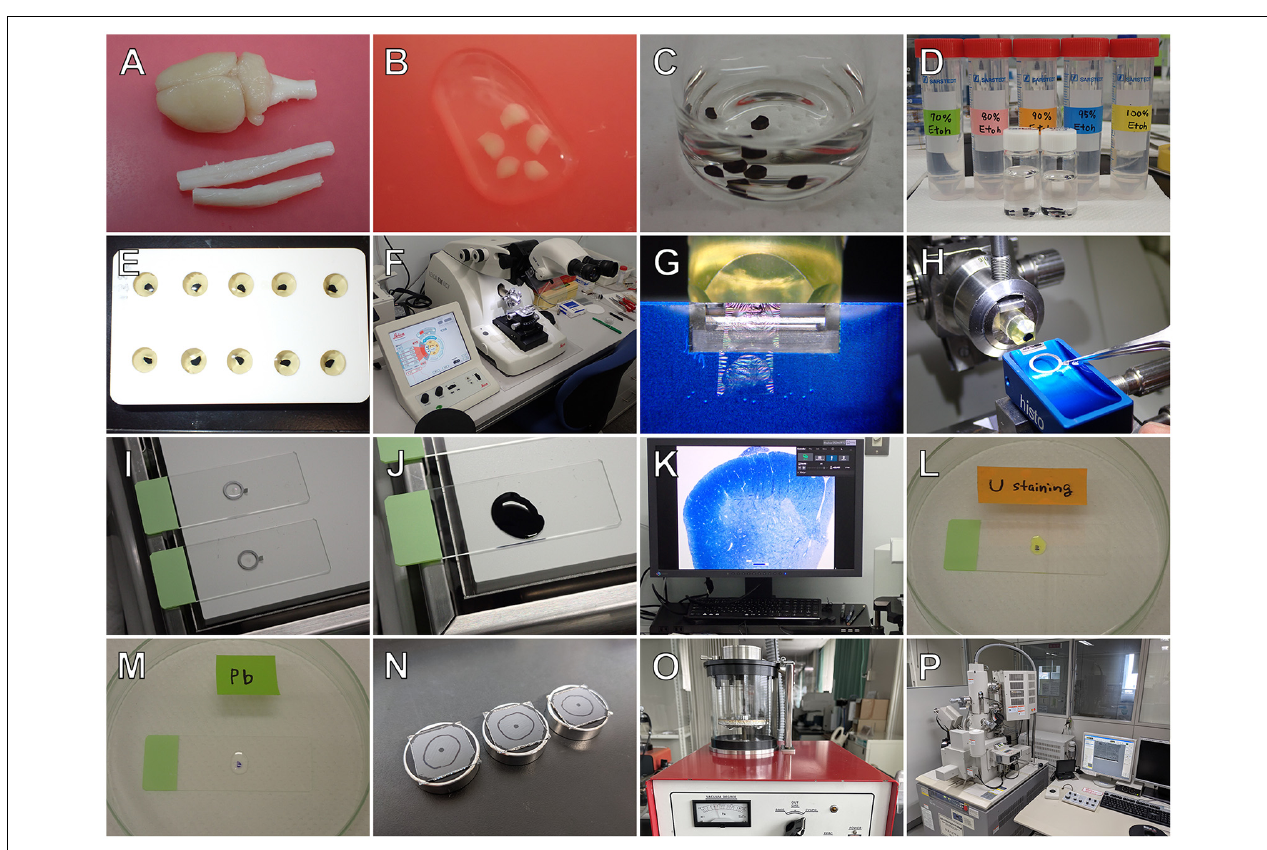
FIGURE 2 | Outline of semithin section SEM. After perfusion fixation, tissues are removed (A) , cut into small pieces (B) , postfixed with osmium tetroxide (C) , dehydrated with a graded series of ethanol (D) , and embedded in epoxy resin (E) . Resin-embedded semithin sections (500-nm thickness) are cut using a Histo knife (Diatome) (G) in an ultramicrotome (EM UC-7; Leica) (F) , picked up with an aluminum loop (Transfer Ring; Microstar) (H) , attached on glass microscope slides by heating on a hot plate (I) , and stained with toluidine blue (J) . The semithin sections are observed using light microscopy (LM) (K) , and the regions of interest are photographed using a charge coupled device camera (DP27; Olympus). The sections are subsequently stained with heavy metals of uranyl acetate (L) and lead citrate (M) , mounted onto aluminum stubs (N) , and coated with carbon using a carbon coater (VC-100S; Vacuum Device) (O) . Finally, the same area of the sections that was previously photographed using LM is observed using a scanning microscope with a backscattered electron detector (SU70; Hitachi) (P)